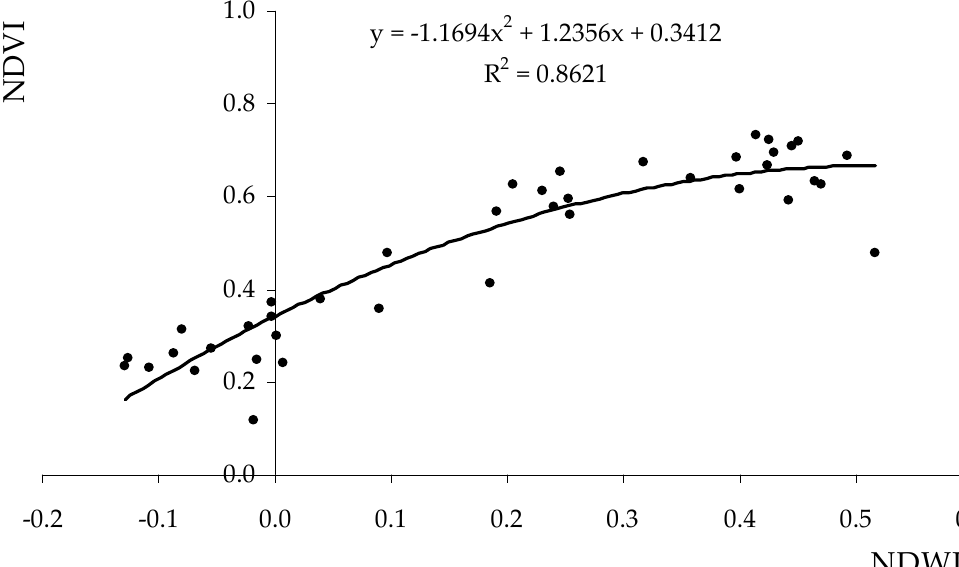
Figure 7. Relationship between normalized difference vegetation index (NDVI) and normalized difference water index (NDWI) over sampling times (between January and June 2016 and between January 2017 and June 2018). Data are average values of 12 sampling points.